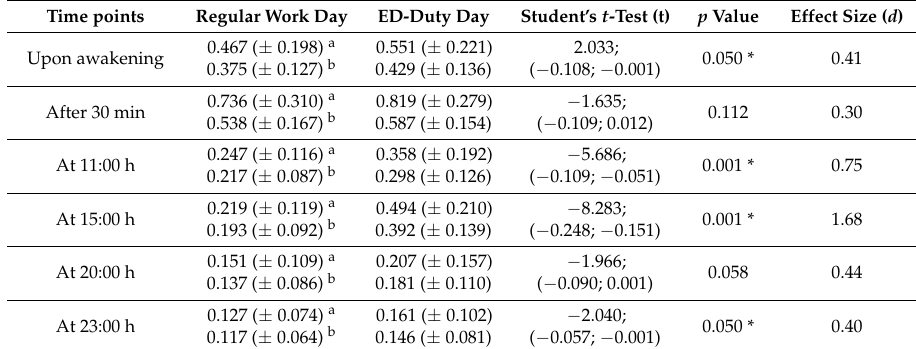
Table 1. Mean cortisol values ( n = 35 residents) on normal versus emergency department (ED)-duty days at each collection